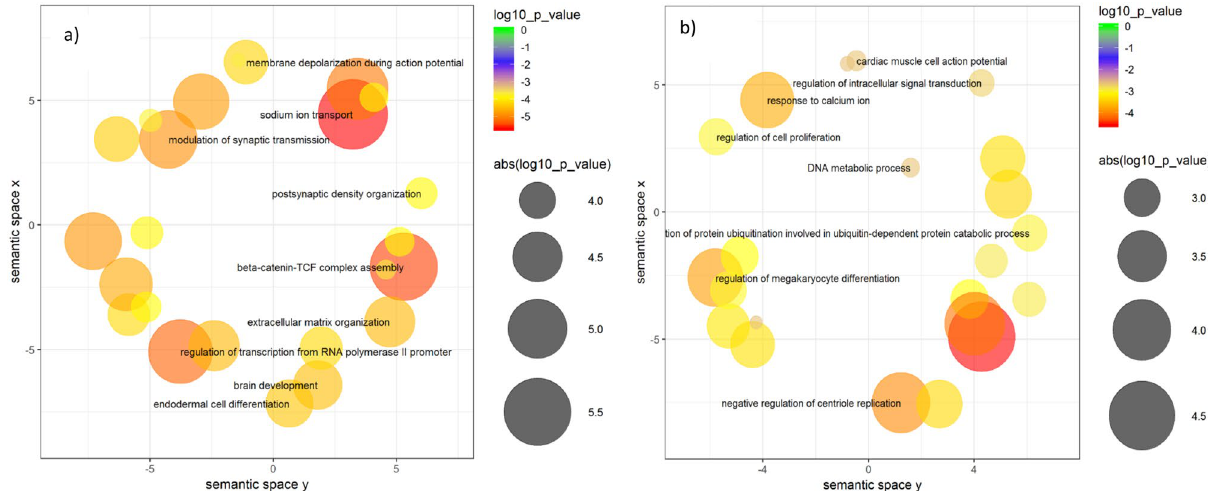
Figure 3. Scatterplots representing the top 30 significant biological processes (combined cohort). ( a ) Top 30 biological processes enriched in genes harboring germinal DNM are shown. ( b ) Top 30 biological processes enriched in genes harboring PZMs DNMs are